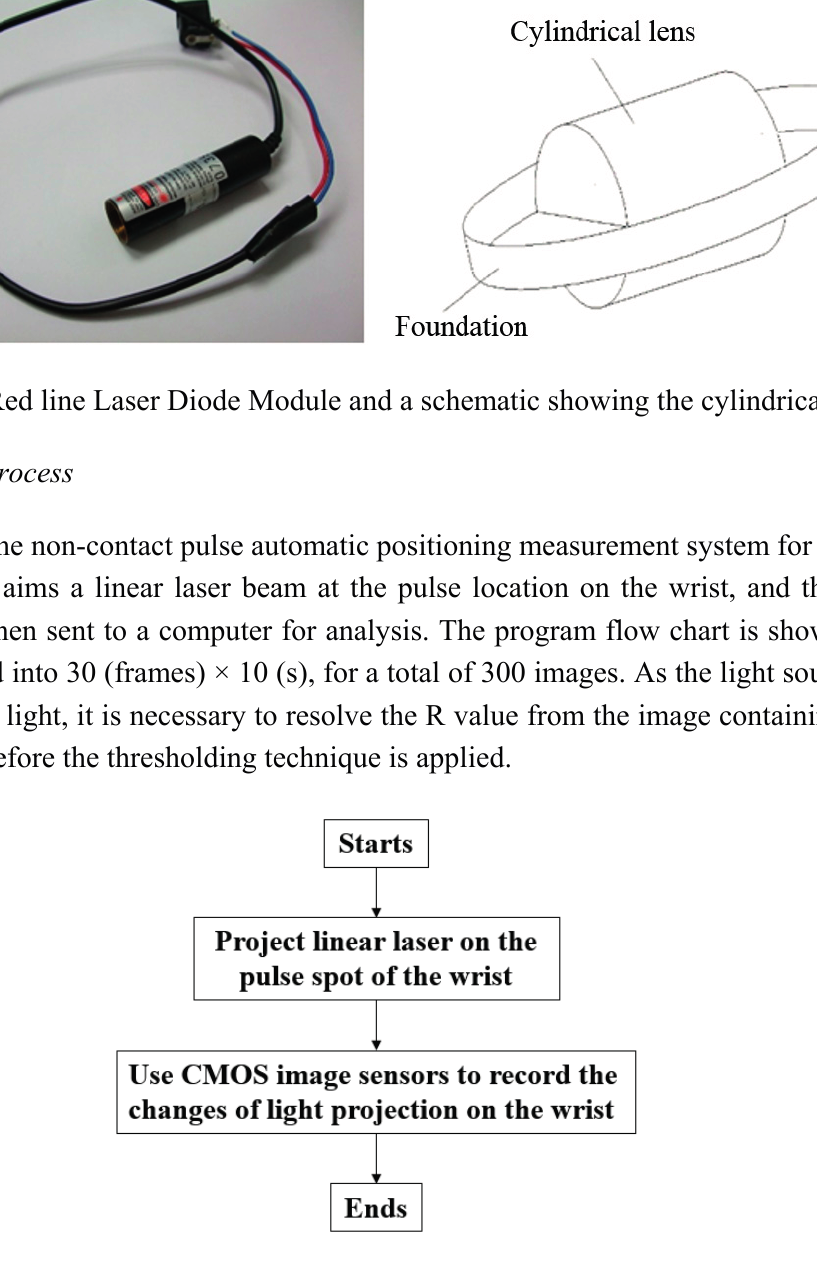
Figure 8. The process for non-contact pulse automatic positioning measurement system for